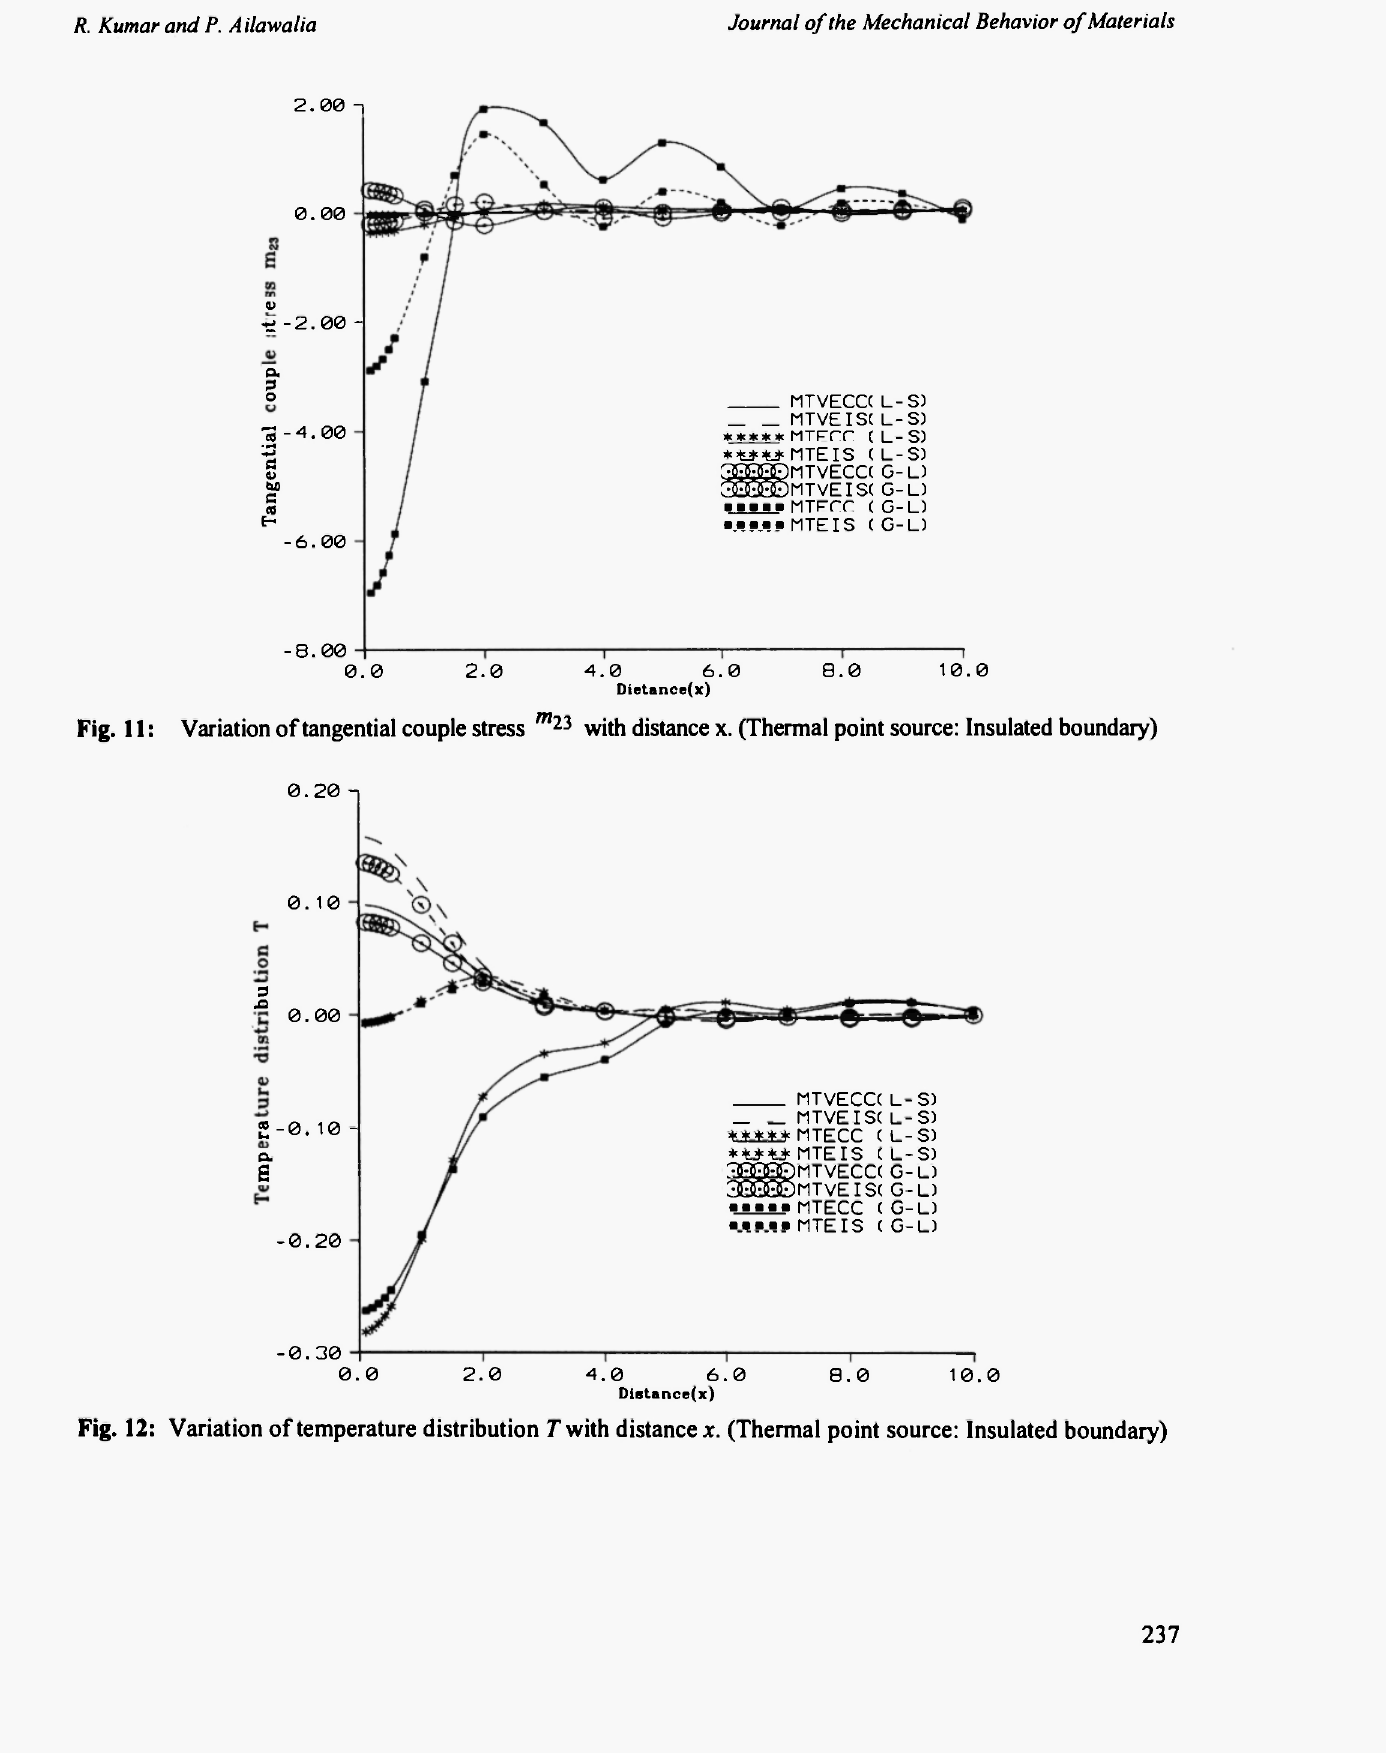
Variation of tangential couple stress ™ 23 with distance χ. (Thermal point source: Insulated boundary)